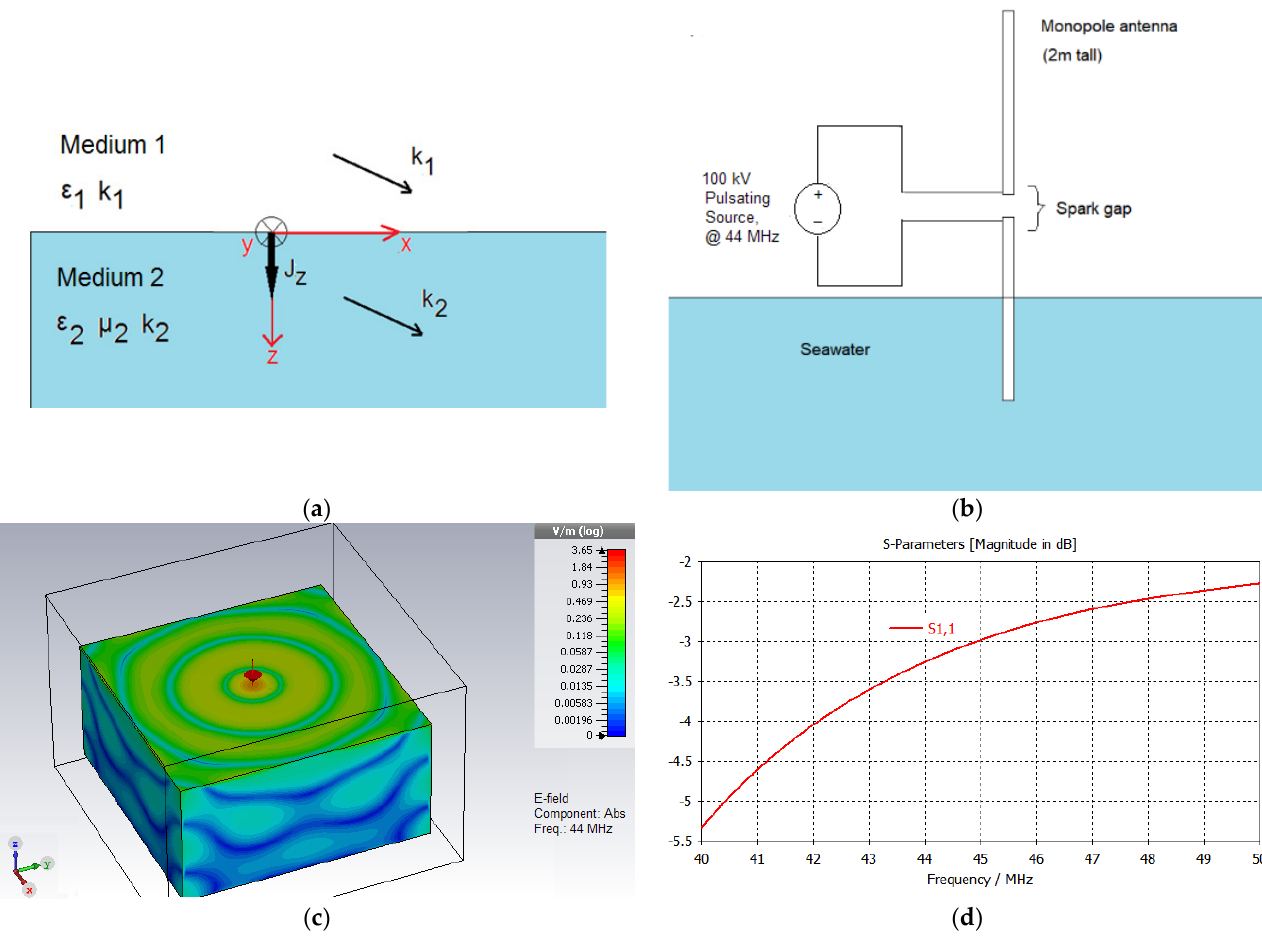
Figure 1. ( a ) Cross-sectional view of an interface between a lossless dielectric material and a lossy dielectric material. ( b ) Excitation of a surface electromagnetic wave on a monopole antenna partially submerged in a seawater, by a 100 kV pulsating source at 44 MHz. ( c ) Simulated surface electromag- netic wave as a result of the monopole antenna setup in ( b ). ( d ) Simulated S1,1 parameters of the setup in ( b